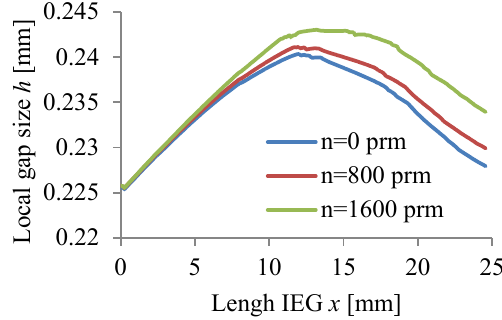
Figure 13. Local gap size distribution h.